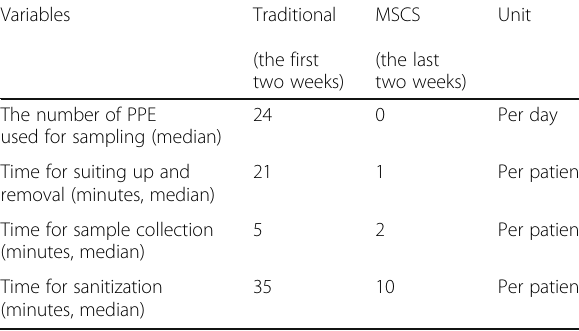
Table 1 Comparing the differences between traditional sampling and the multifunctional sample collection station (MSCS) during the 4-week observation period Variables Traditional